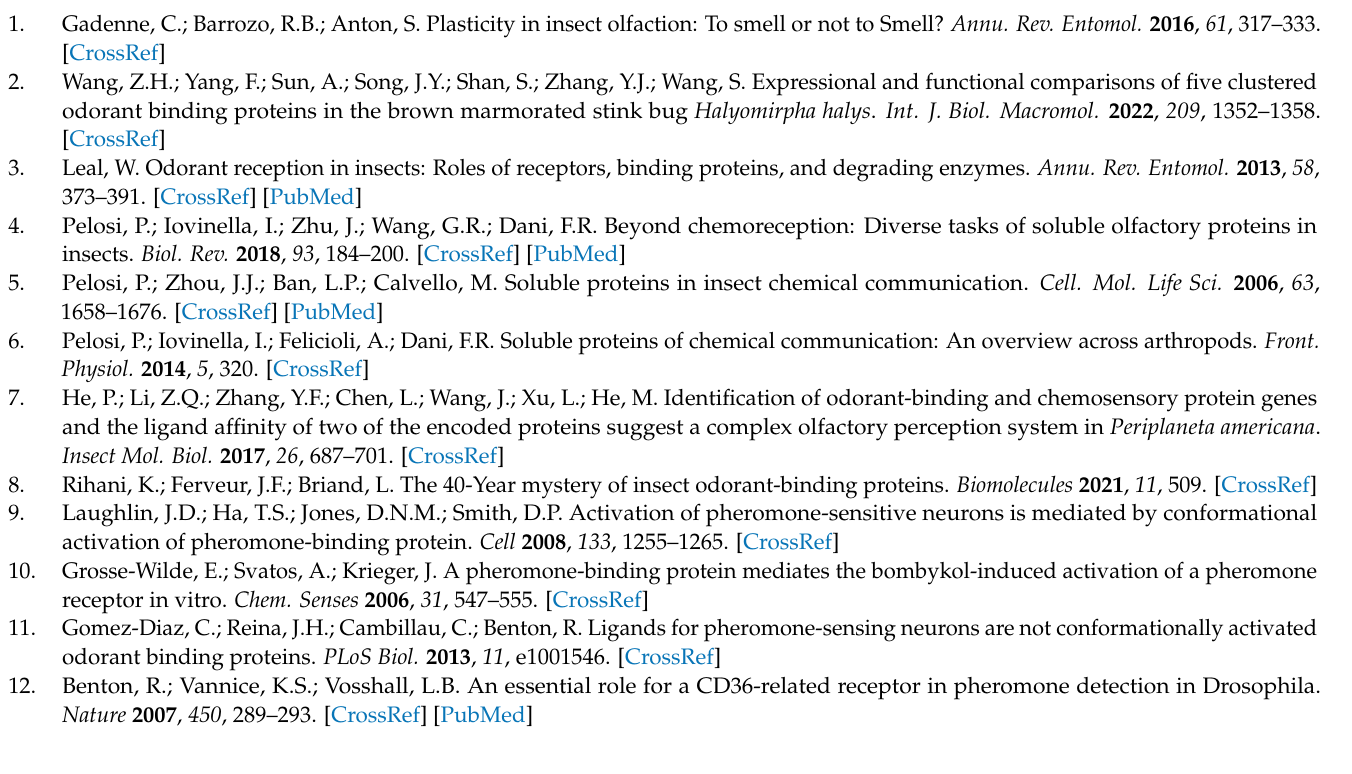
struct the phylogenetic tree. Table S2. CSP sequences used to construct the phylogenetic tree. Table S3. Primers used for qRT-PCR analysis of OBP and CSP genes of N. cincticeps . Table S4. Overall profile analysis of sequencing data. Table S5. The summary of distribution of assembled length in N. cincticeps transcriptome. Table S6. The number of unigenes annotated in different database. Figure S1. Species distribution of top best hits of the BLASTx results. Figure S2. Gene Ontology (GO) classification of the 46,623 unigenes of N. cincticeps . Figure S3. KEGG classification of the 46,623 unigenes N. cincticeps